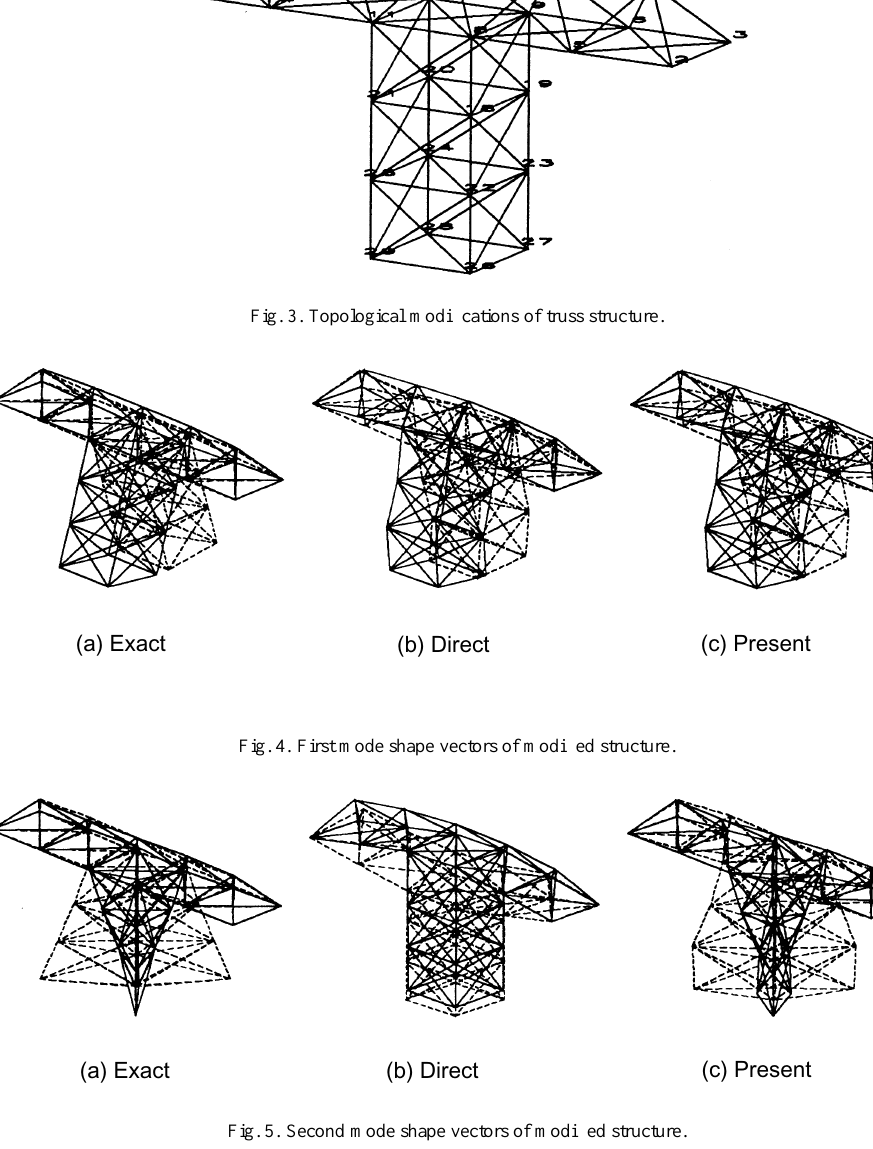
Fig. 5. Second mode shape vectors of modified